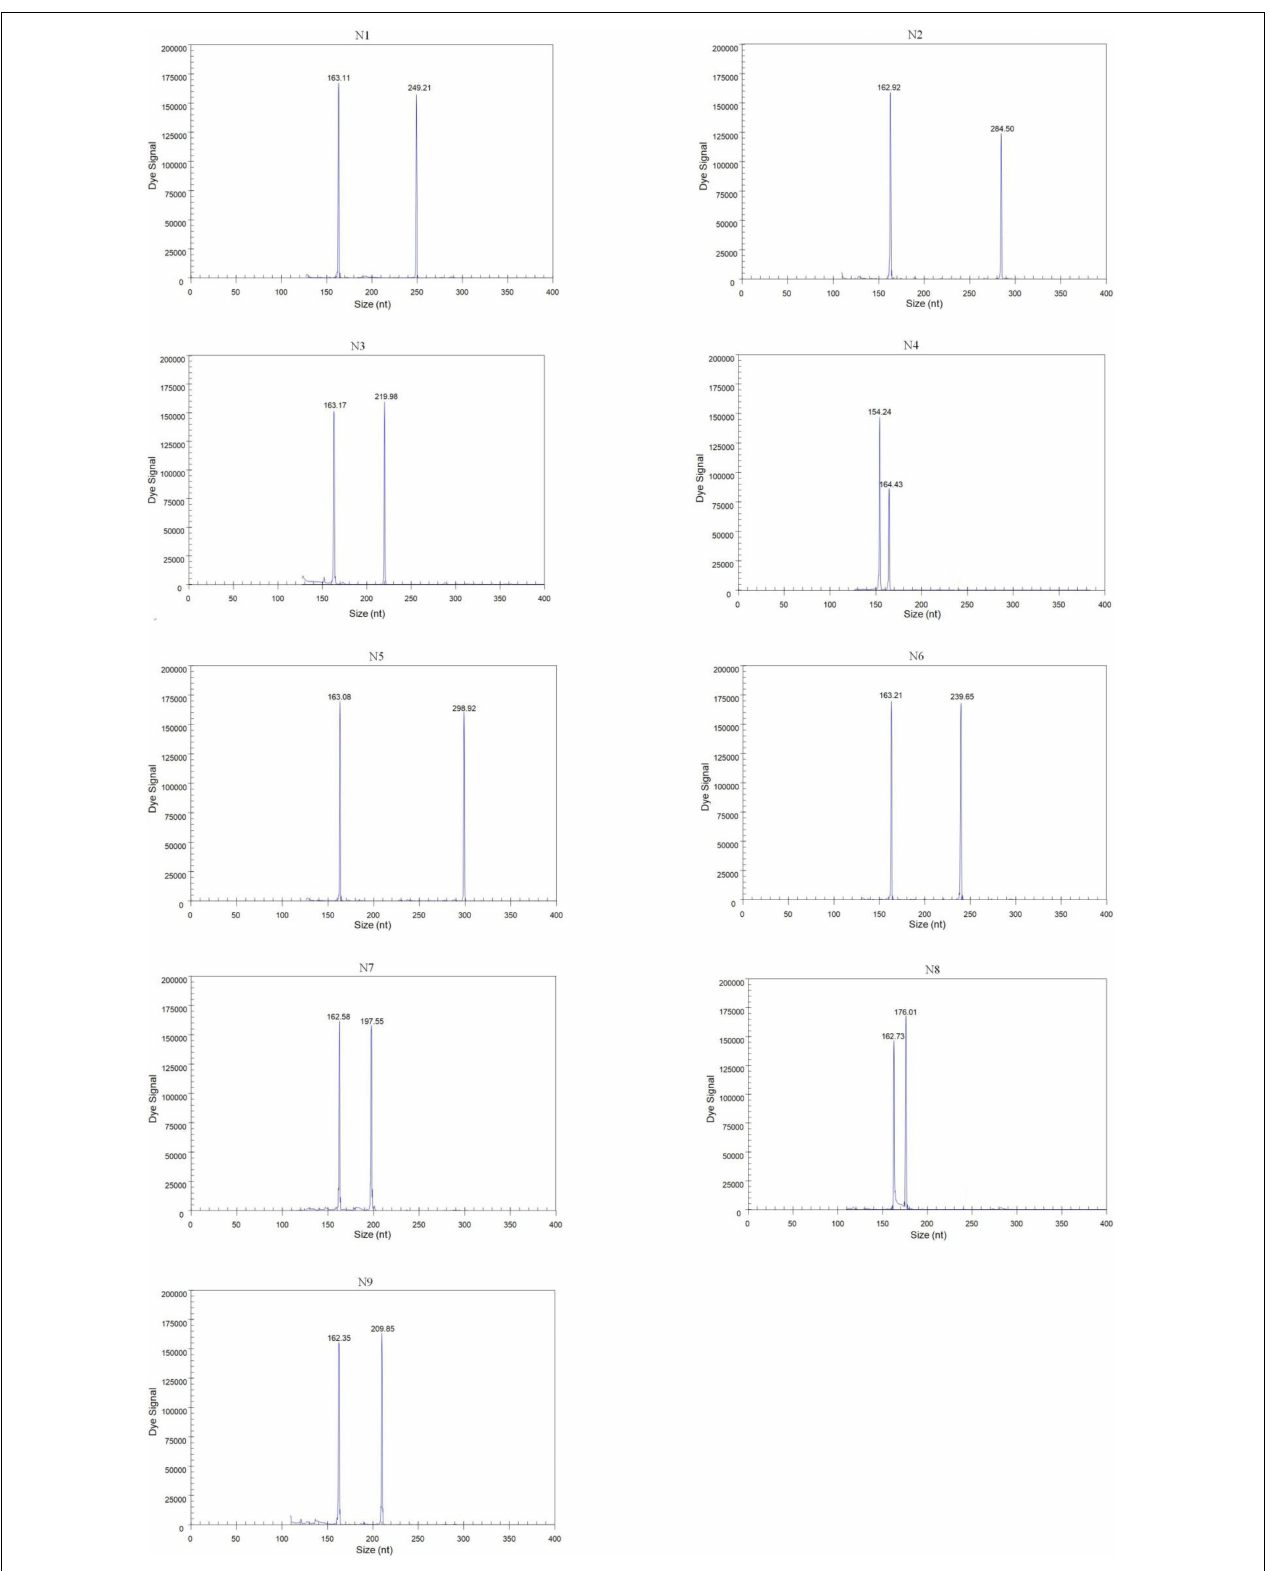
FIGURE 1 | Detection of single AIV subtypes using GeXP multiplex RT-PCR. The Y -axis indicates the fluorescence signal in arbitrary units, and the X -axis indicates the actual size of the PCR product.